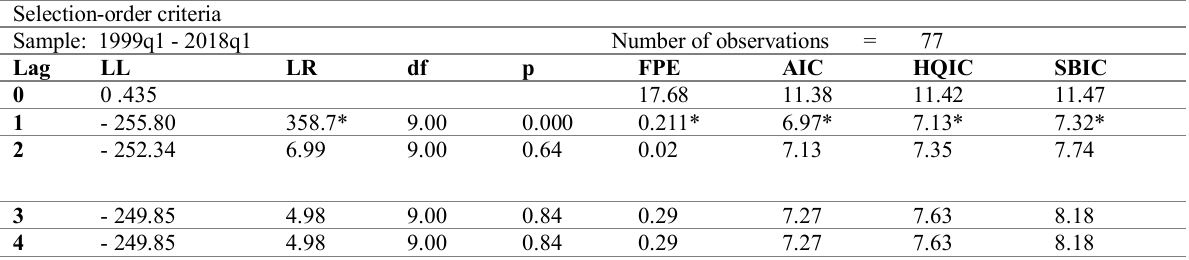
Table 5: Determination of the maximum number of lags for model variables